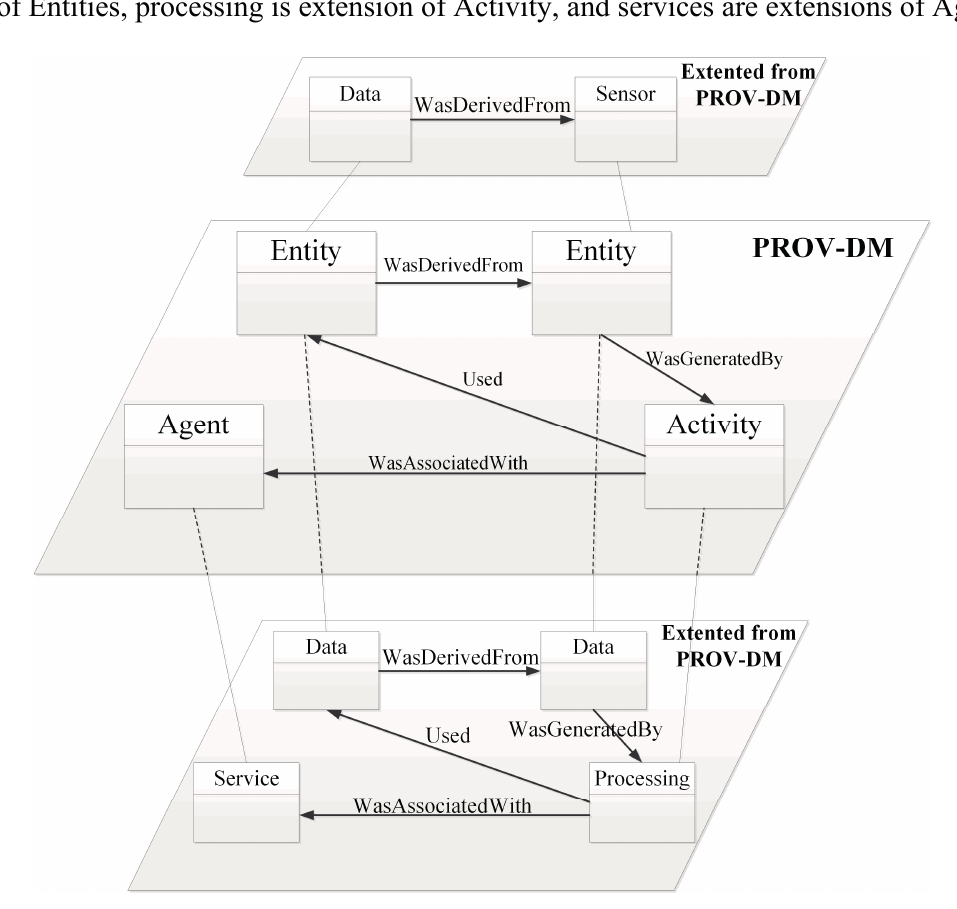
Figure 2. Formalized description of the provenance model extended from